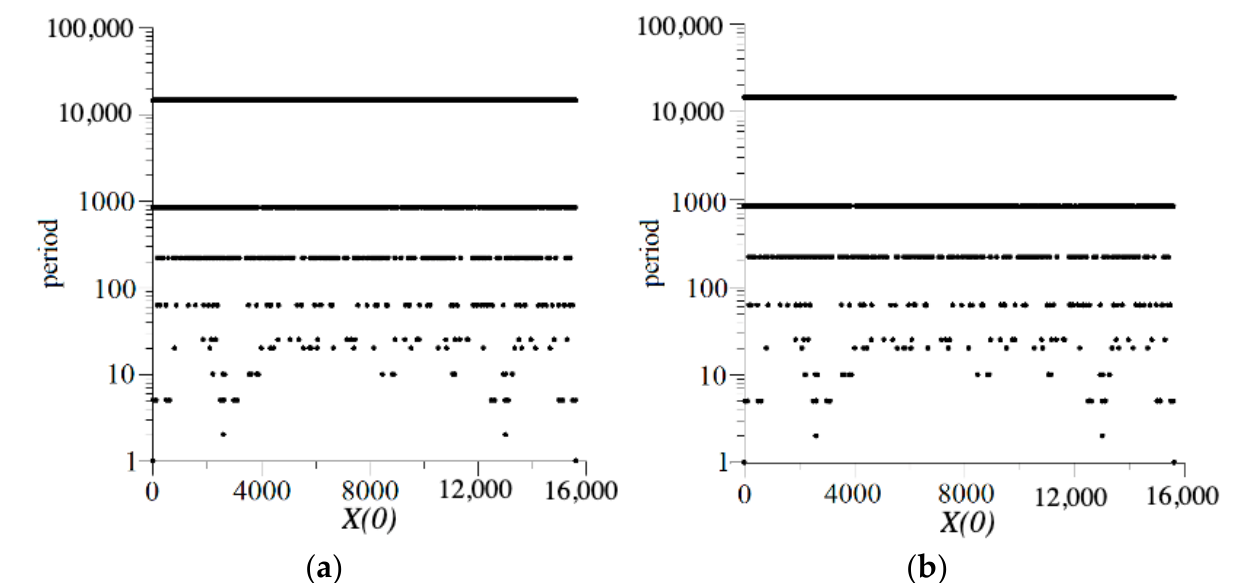
Figure 5. Dependencies of repetition periods from X (0): ( a ) hardware model: p = 5, n = 3, A = 2 n − p = 3, a = b 0 ⊕ b 1 ⊕ b 2 , X (0) = 0 ÷ p 6 − 1; ( b ) abstract model: p = 5, a = b 0 ⊕ b 1 ⊕ b 2 , X (0) = 0 ÷ p 6 − 1.